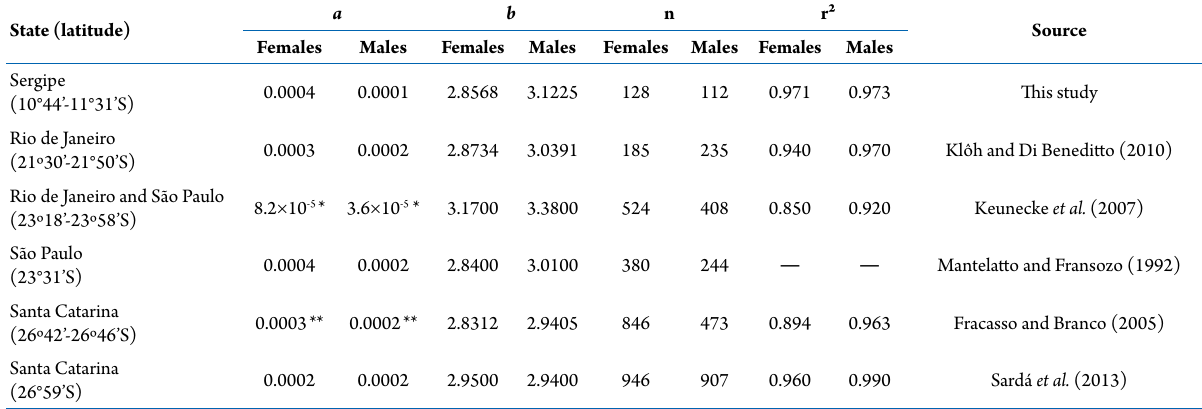
) and maximum carapace length (CW m